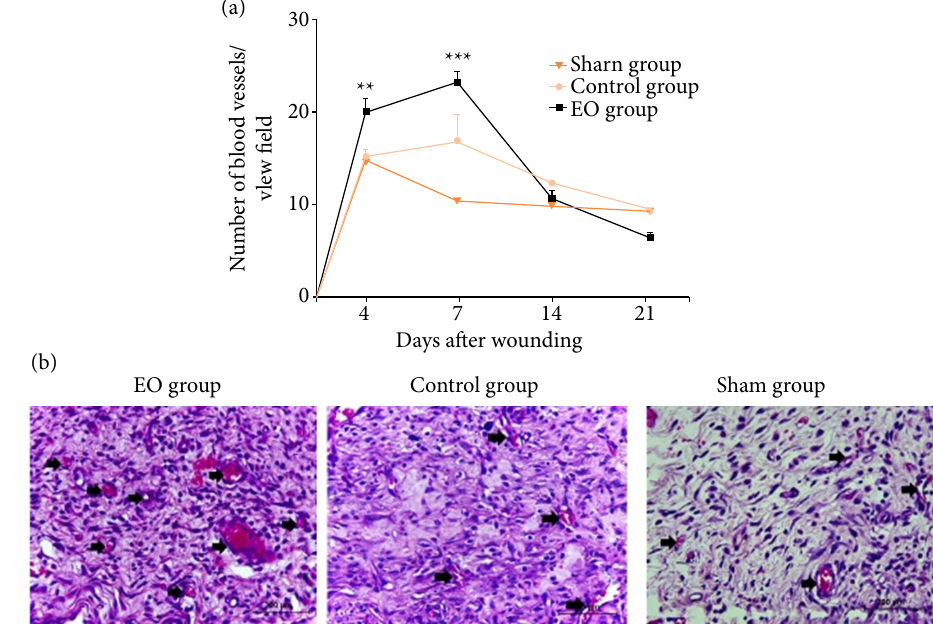
Figure 3 - Angiogenesis was increased in the essential oil treated group (EO). (a) Kinetics of blood vessel count. (b) Representative photomicrographs of H/E-stained histological sections 7 days after wounding. Arrows indicate blood vessels. Data are expressed as mean ± SEM, n = 5 for each time point and group. ** p < 0.01 – EO group versus CG and Sham groups at 4th day after wounding; *** p < 0.001 – EO group versus CG and Sham groups 7 days after wounding. Two-way ANOVA. Scale bar: 200 μ